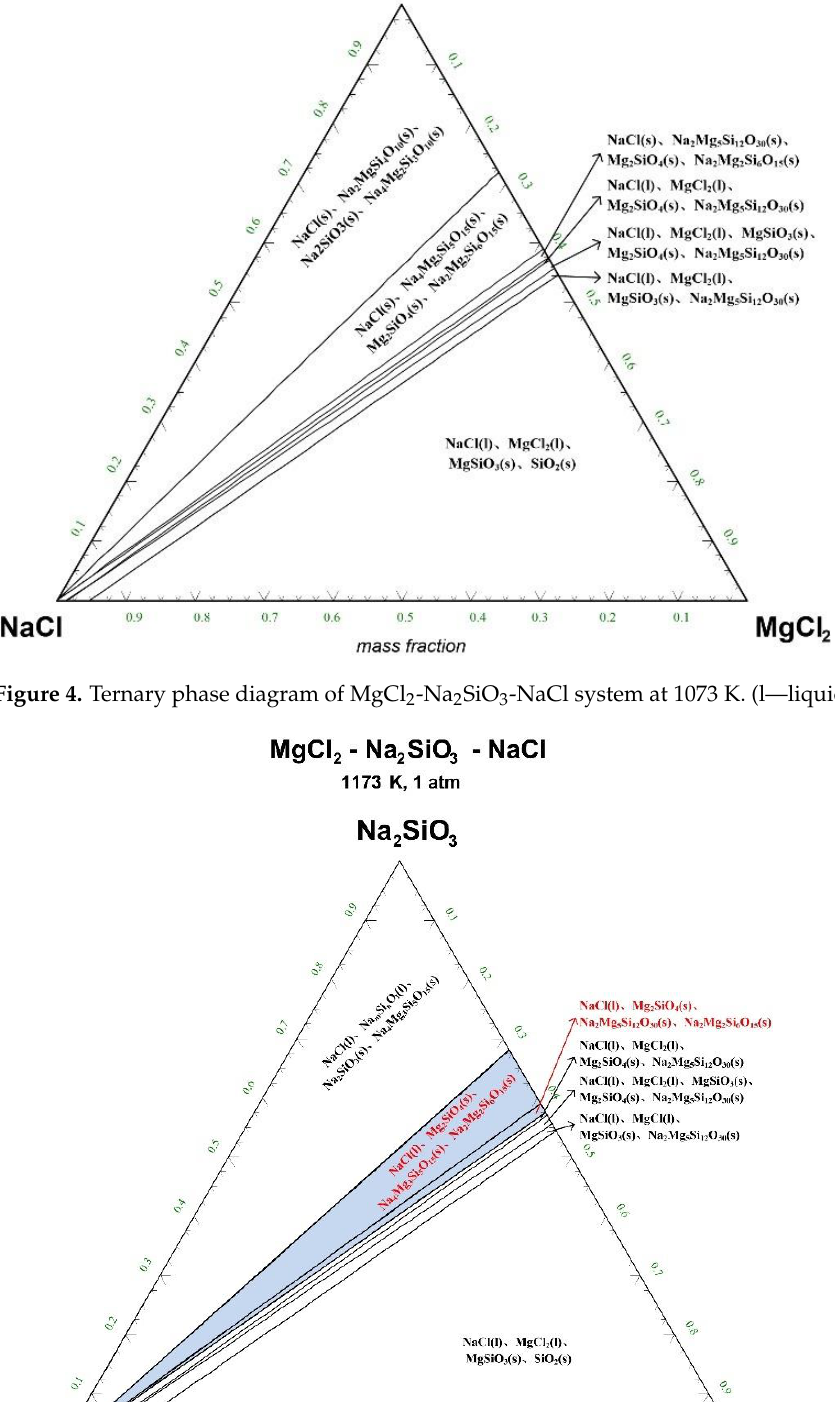
Figure 6. Ternary phase diagram of MgCl 2 -Na 2 SiO 3 -NaCl system at 1273 K. (l — liquid; s — solid).